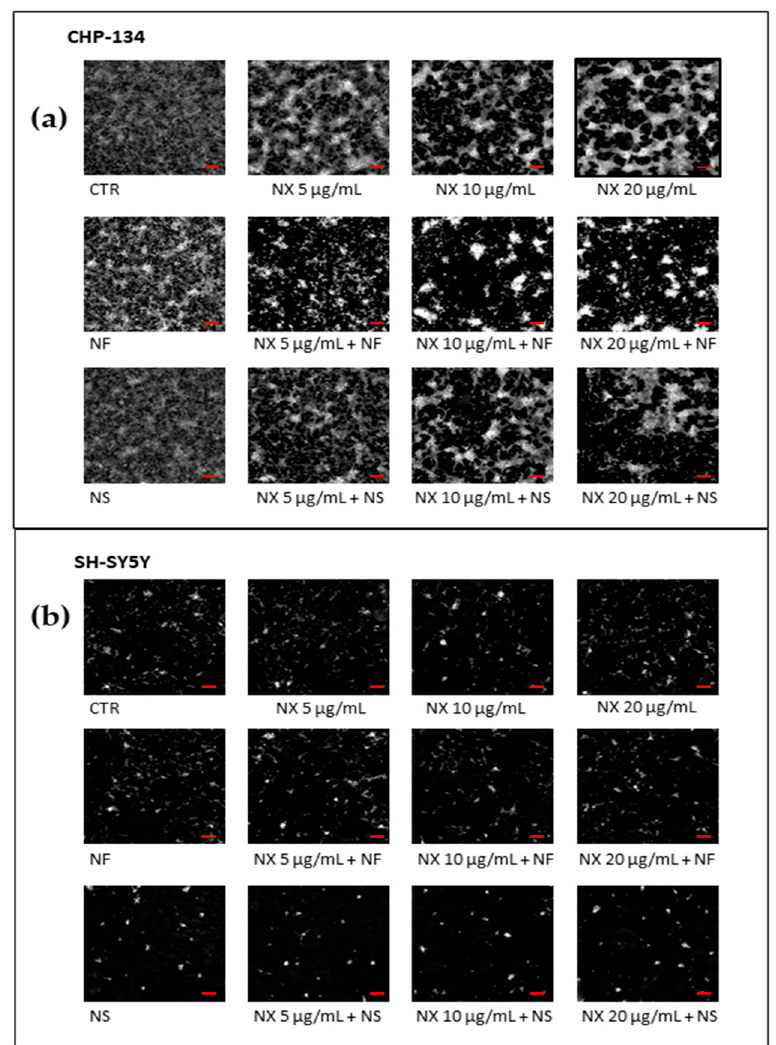
Figure 6. Representative images at 72 h of ( a ) CHP-134 and ( b ) SH-SY5Y cells treated with NX at 5, 10, and 20 µg/mL, or NF, NS (0.05 mg/mL), NX in combination with NF, and NX in combination with NS. Photographs were taken at 10X magnification, bar = 10 µm.